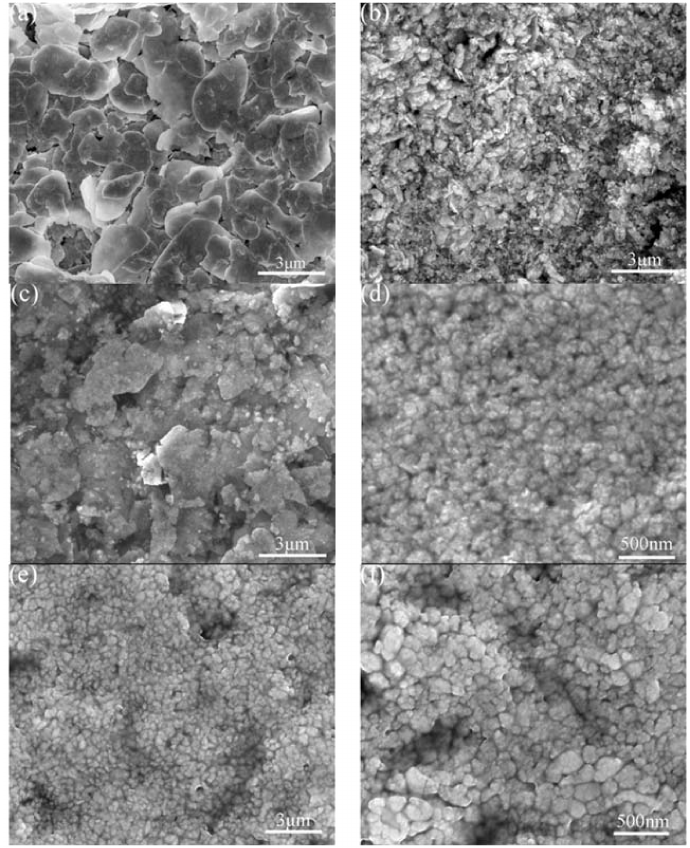
Figure 2. The SEM images of ball-milled tungsten powder at different milling time with different milling speeds: ( a ) 300 rpm, 30 h; ( b ) 300 rpm, 60 h; ( c ) 500 rpm, 30 h; ( d ) 500 rpm, 60 h; ( e ) 700 rpm, 30 h; ( f ) 700 rpm, 60